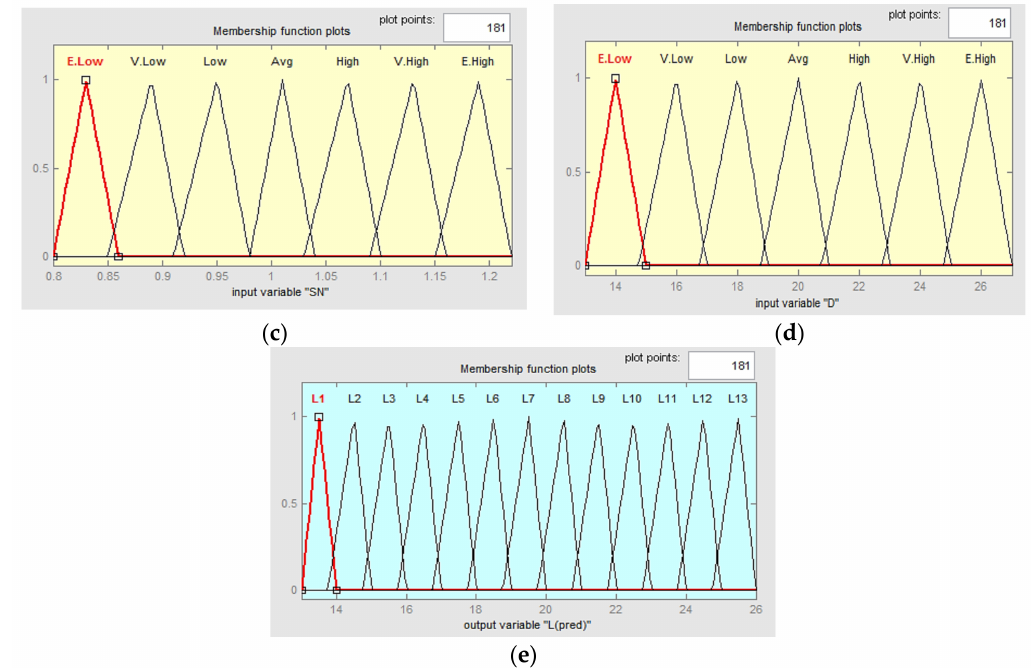
Figure A2. Membership functions for (a) level; (b) growth rate; (c) seasonality; (d) demand; and (e) predicted